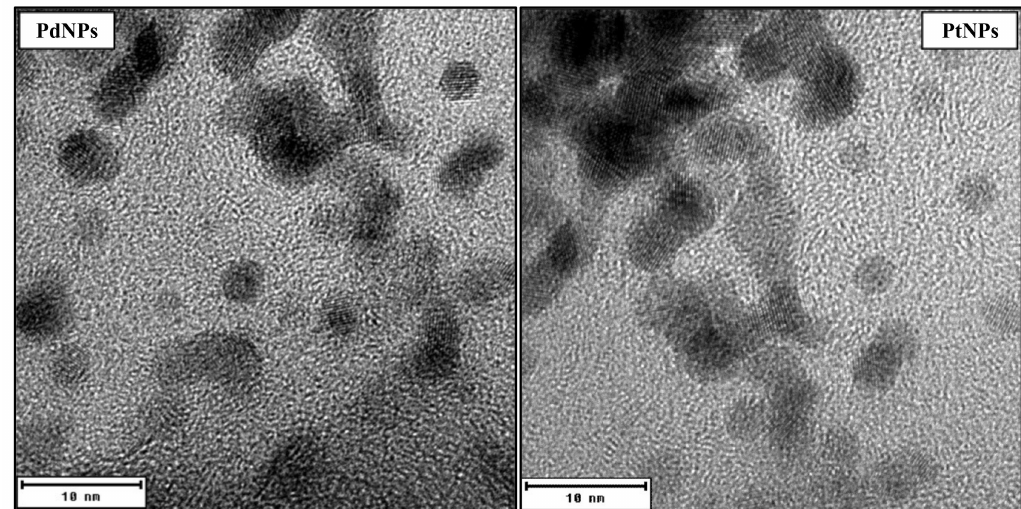
Figure 5. HR-TEM images of round shape palladium nanoparticles (PdNPs) and platinum nanoparticles (PtNPs) with size 4–6 nm.